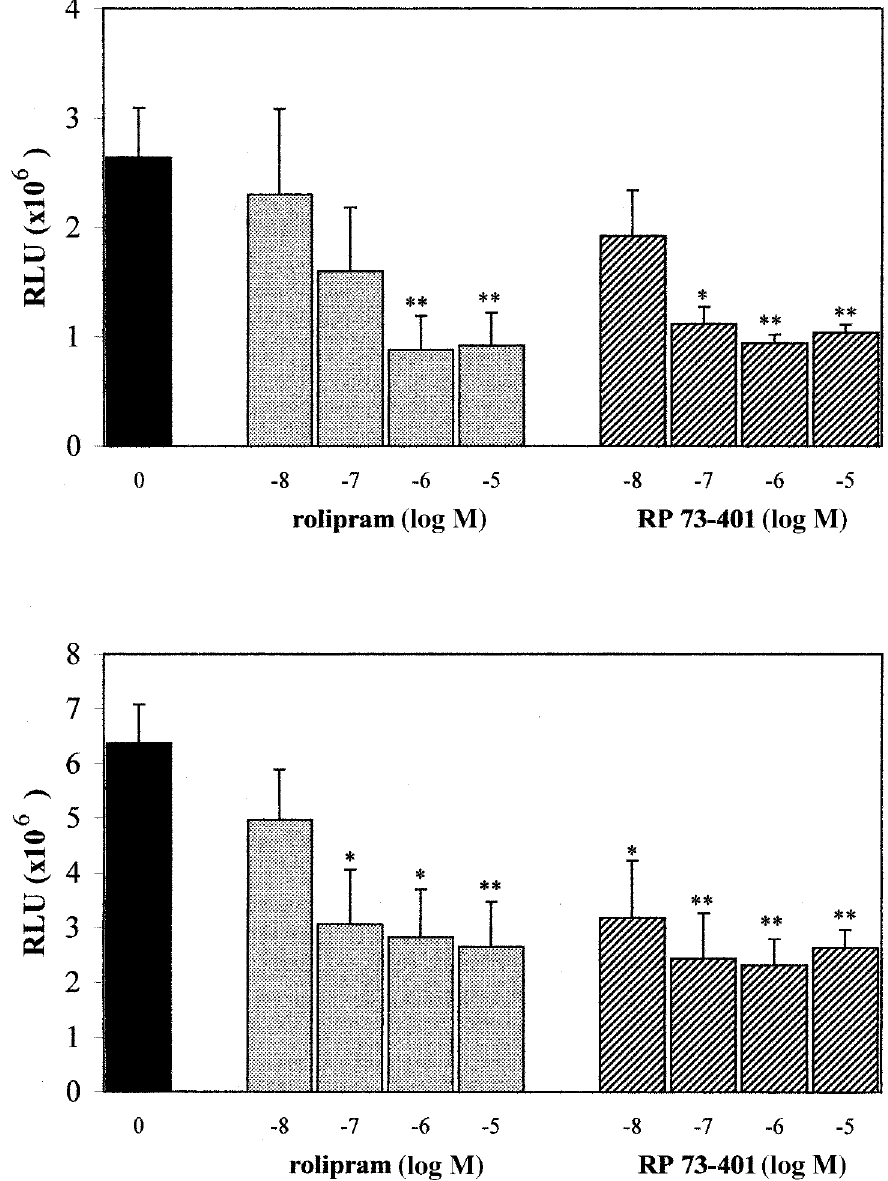
FIG. 2. Effects of rolipram (10 –8 to 10 –5 M), RP 73–401 (10 –8 to 10 –5 M), or vehicle on fMLP-induced increased in superoxide anion production (expressed in relative light units (RLU)) from peripheral blood mononuclear cells pretreated (lower panel) or not (upper panel) with lipopolysaccharide (10 m g/ml for 30min). * p < 0.05, ** p < 0.01 in comparison with non-treated (control) cells ( n =